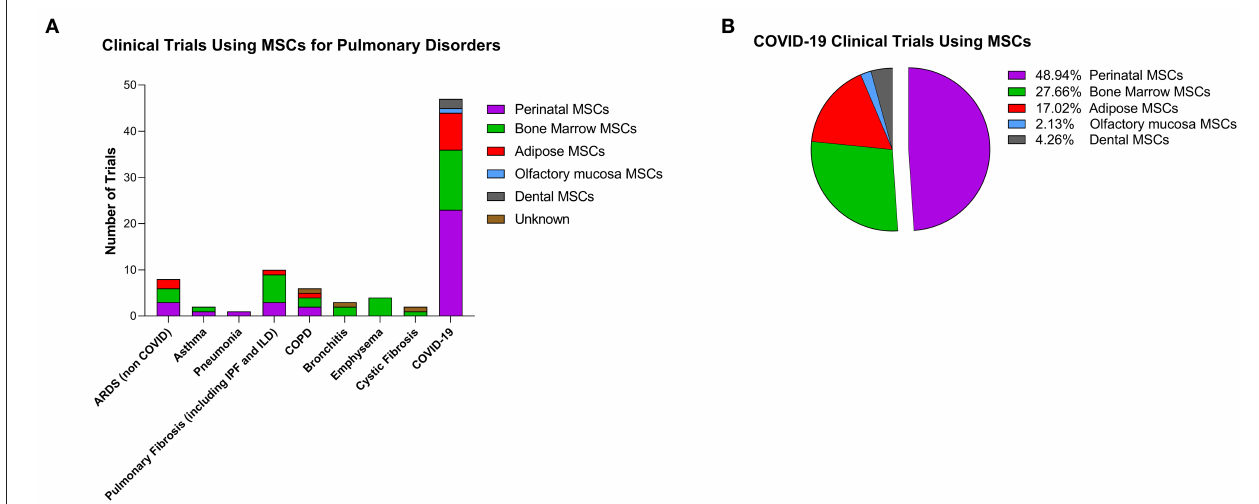
FIGURE 1 | Clinical trials using cell-based therapy for pulmonary disorders. (A) Clinical trials as reported on clinicaltrials.gov (as of July 1, 2020) with stromal cells for pulmonary conditions. Colors represent the different cells used in the studies. ARDS, acute respiratory distress syndrome; IPF, idiopathic pulmonary fibrosis; ILD, interstitial lung disease; COPD, chronic obstructive pulmonary disease. (B) Percentage of MSCs from different tissues used in COVID-19 clinical